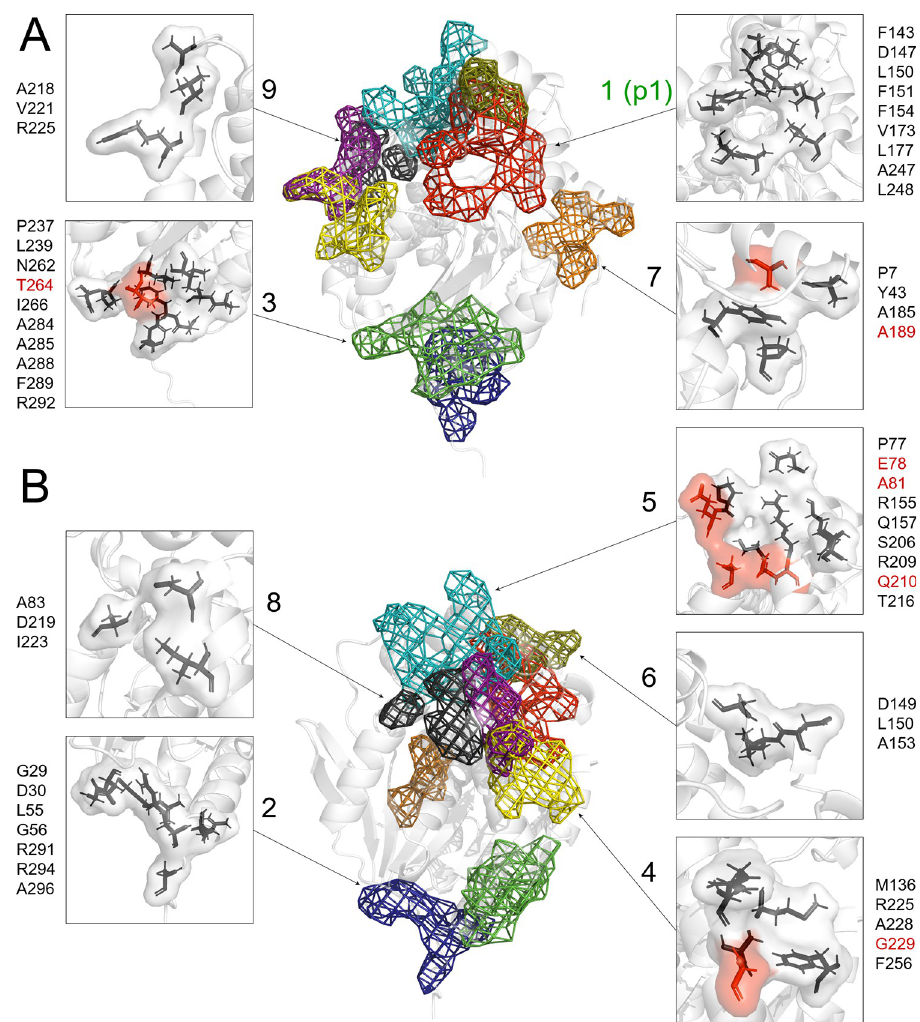
Fig 1. Structure of haloalkane dehalogenase LinB. LinB shown as a white cartoon representation with marked transient binding sites presented as a coloured mesh. LinB is shown in two orientations: (A) and (B). The side panels show zoomed-in views of transient binding sites along with their building residues shown as black sticks. Residues associated with a given transient binding site are indicated on the sides. Residues that were chosen for substitution are shown as red sticks and are labelled in red. Signatures above the arrows include the identifier of the transient binding